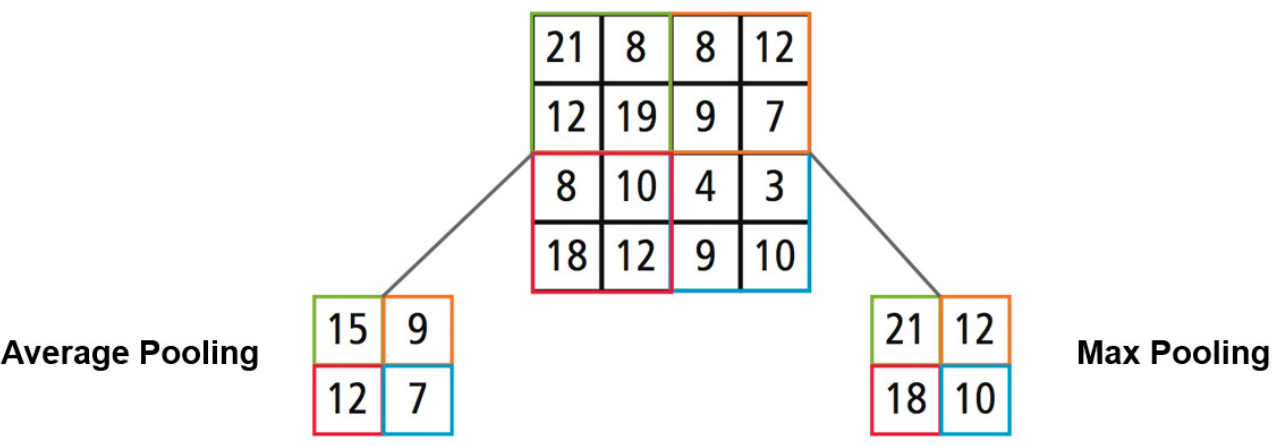
Figure 6. Average pooling and max pooling [1].